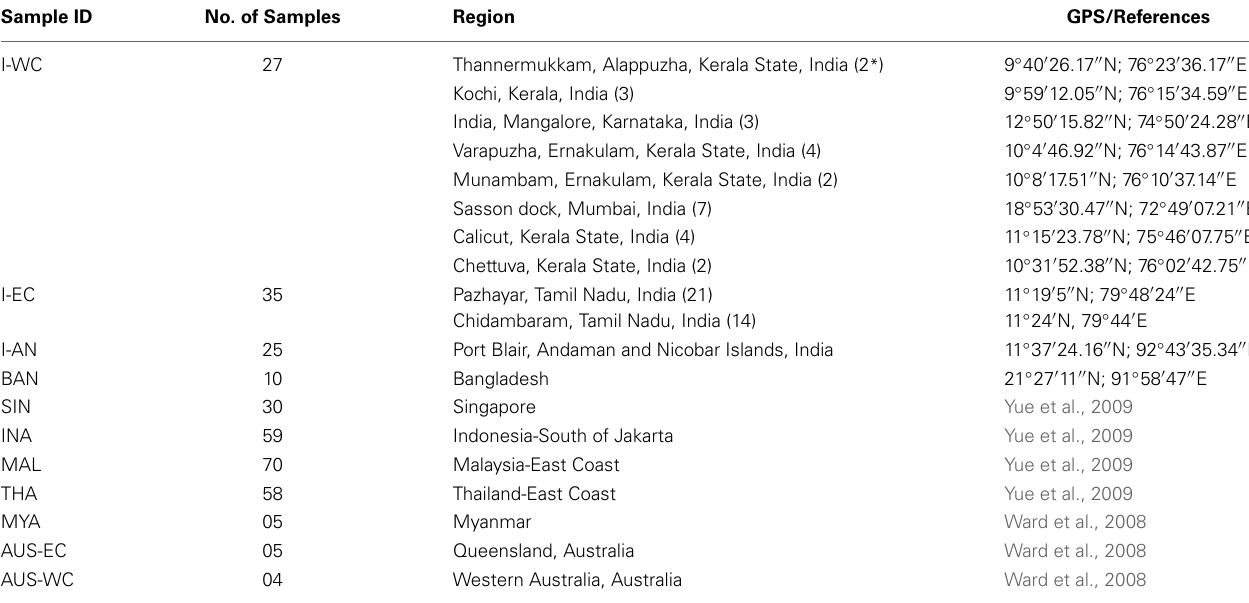
Table 1 | Details of Asian seabass samples representing various Indo-West Pacific regions used in the study. Sample